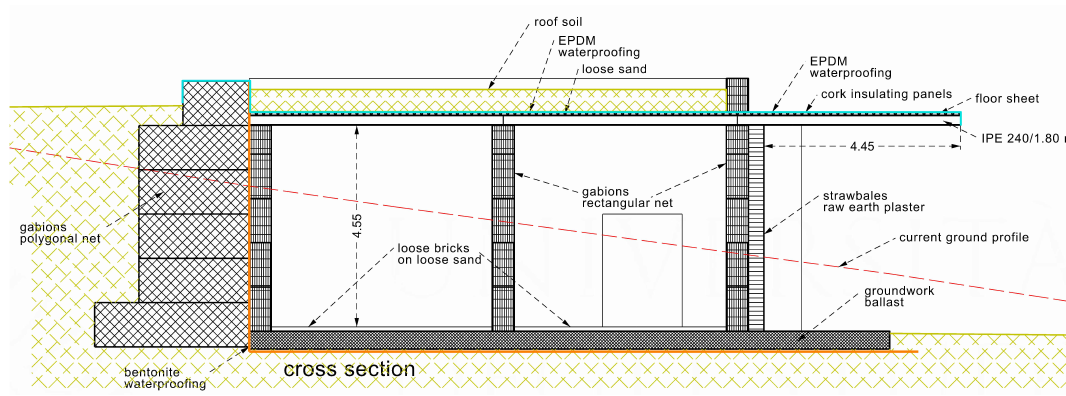
Figure 1. The building’s ground plan.